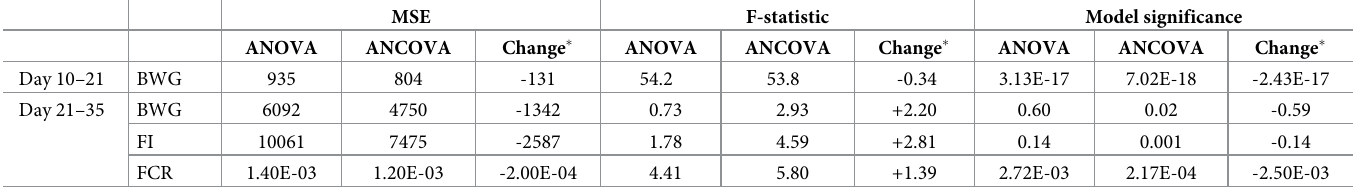
Table 8. MSE, F-statistic and model significance of performance data when analysed by a one-way ANOVA and ANCOVA during different phases for Experiment 3. MSE